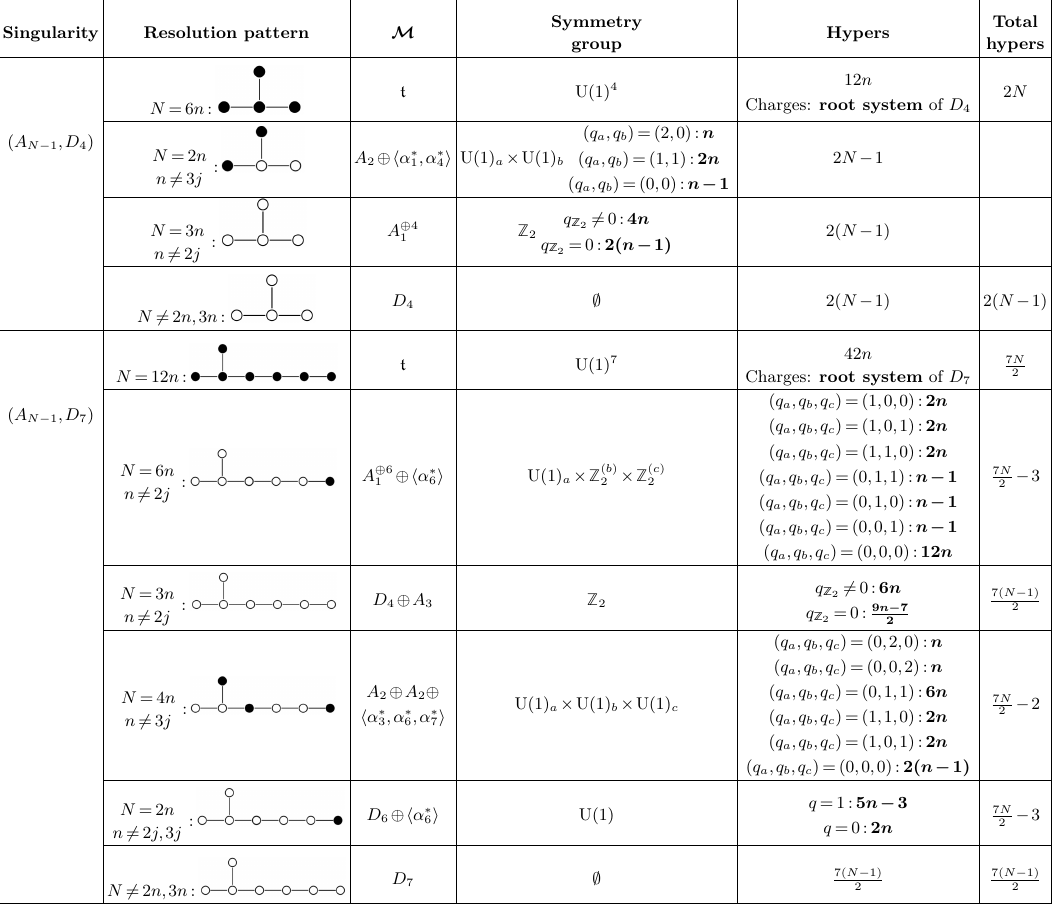
Higgs branch data for quasi-homogeneous cDV singularities of ( A ( A ) N − 1 , D 7